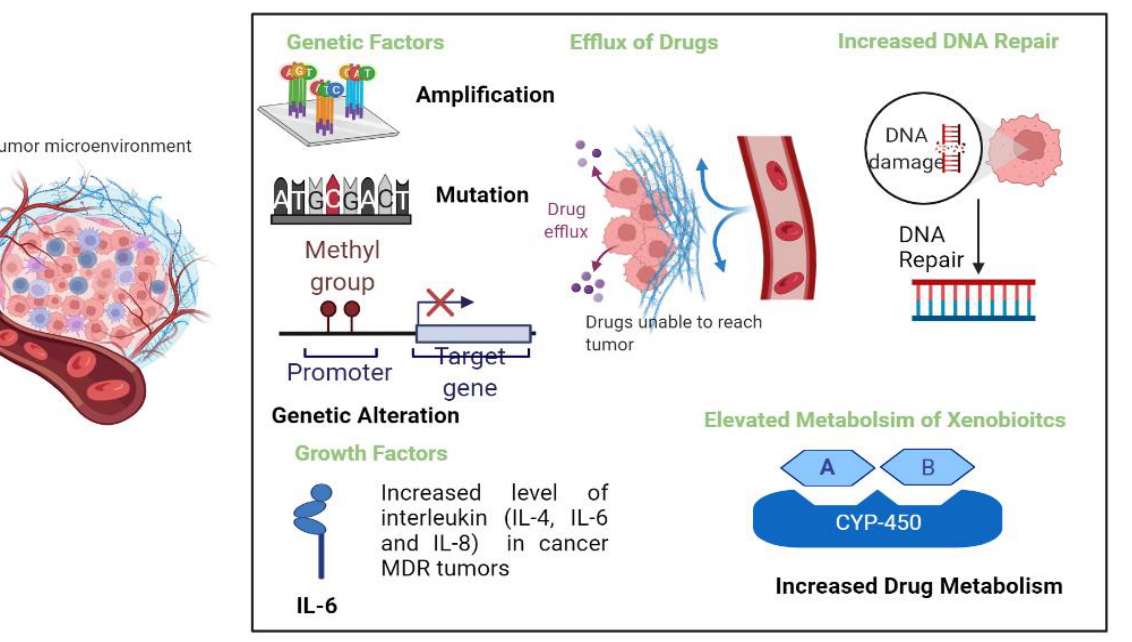
Figure 1. Different mechanisms of multidrug resistance in tumor cells, namely efflux of drugs, genetic factors, growth factors, elevated metabolism of xenobiotics, and increased DNA repair.